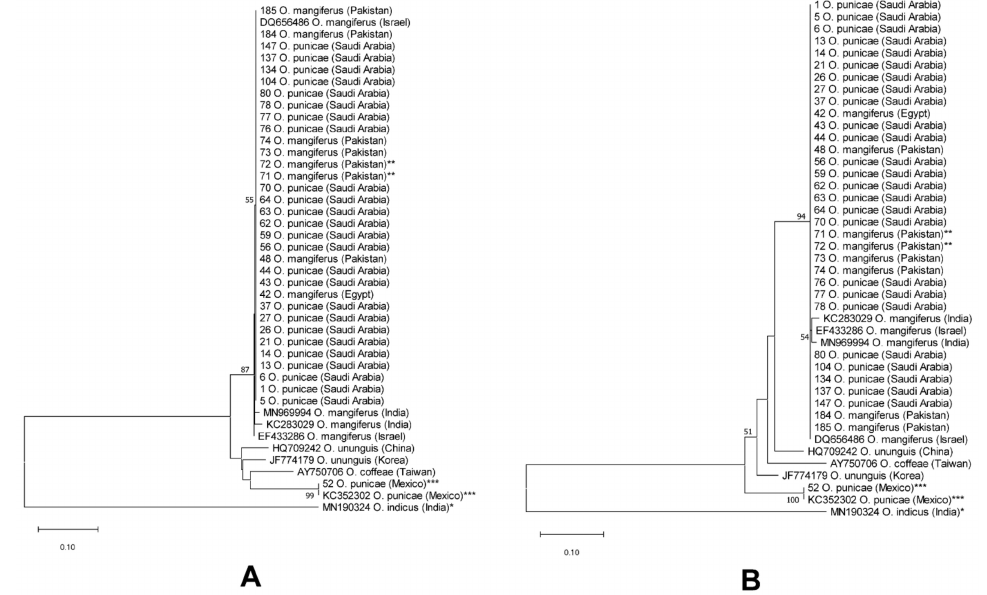
Figure 6. NJ ( A ) and ML ( B ) phylogenetic trees based on ITS2 sequences of 43 spider mite samples, representing different populations of four closely related Oligonychus species. A total of 25 ITS2 sequences were obtained/analyzed from different hosts and regions in Saudi Arabia, one from Egypt, and seven from Pakistan ( ** including two samples of Oligonychus mangiferus collected from the exact locality whence the original type was previously collected and described for the first time) [9]. Whereas 10 closely related ITS2 sequences were analyzed of O. coffeae, O. mangiferus, O. ununguis , and a cryptic Oligonychus species (*** previously claimed as O. punicae in Mexico) [37] that needs to be re-identified; in addition, O. indicus (* an Oligonychus species from the other subgenus Reckiella Tuttle and baker, used as an out-group taxon). Numbers on tree branches are bootstrap values obtained from 1000